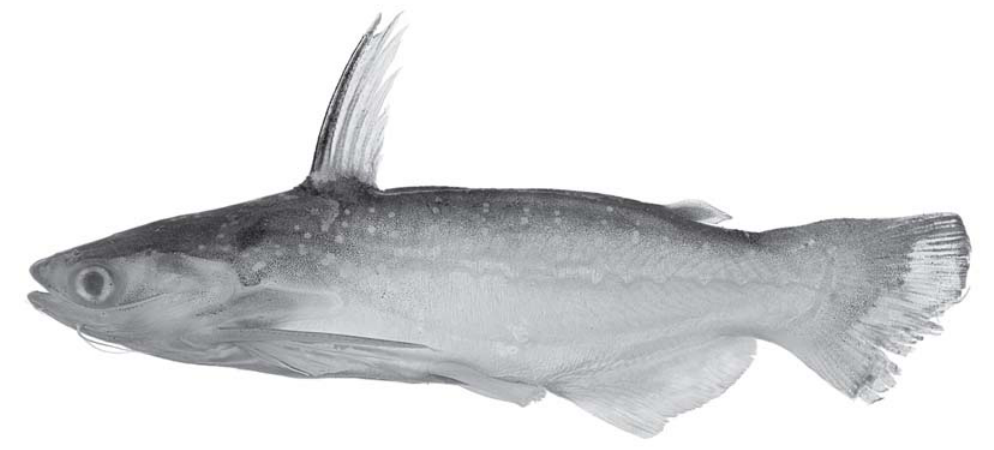
Fig. 3. Auchenipterichthys coracoideus , coloration in alcohol, ANSP 178446, 94 mm SL; Río Nanay, at Pampa Chica, village 4.54 km W of Iquitos (3°45’09"S,